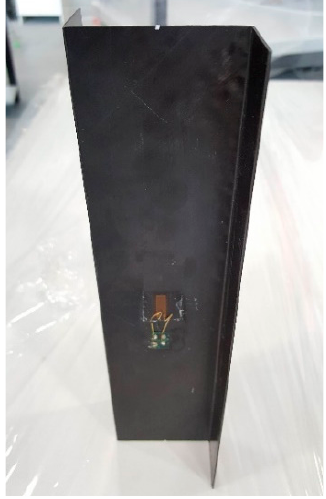
Figure 1. Real object of the study made of CFRP.